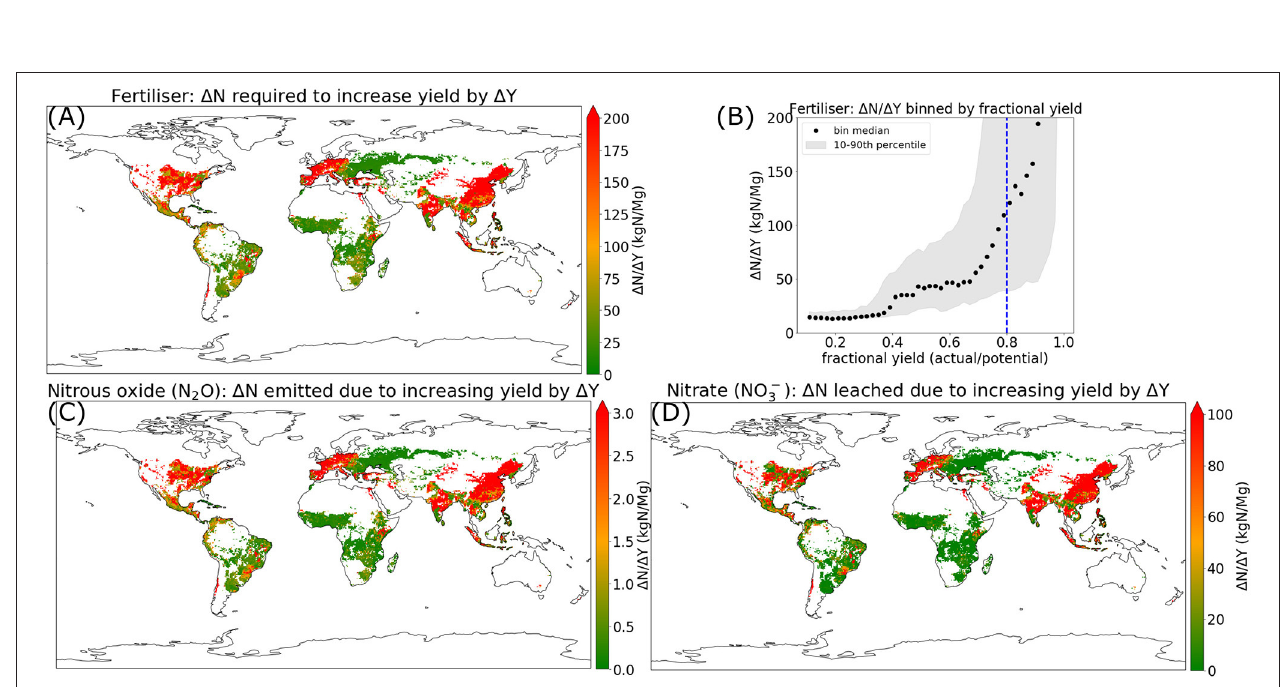
FIGURE 2 | The additional N inputs and losses associated with yield increases, measured as kg’s of additional N ( 1 N) per Mg of additional production ( 1 Y). (A) 1 N/ 1 Y for N-fertilizer inputs. (B) The dependence of 1 N/ 1 Y for N-fertilizer on the fractional yield. Grid cells are sorted into bins according to their fractional yield (width 0.02). For each bin, the median value of 1 N/ 1 Y is shown as a black dot and the spread (10th − 90th percentiles) by the gray shaded region. (C) 1 N/ 1 Y for direct and indirect N 2 O emissions. (D) 1 N/ 1 Y for NO − 3